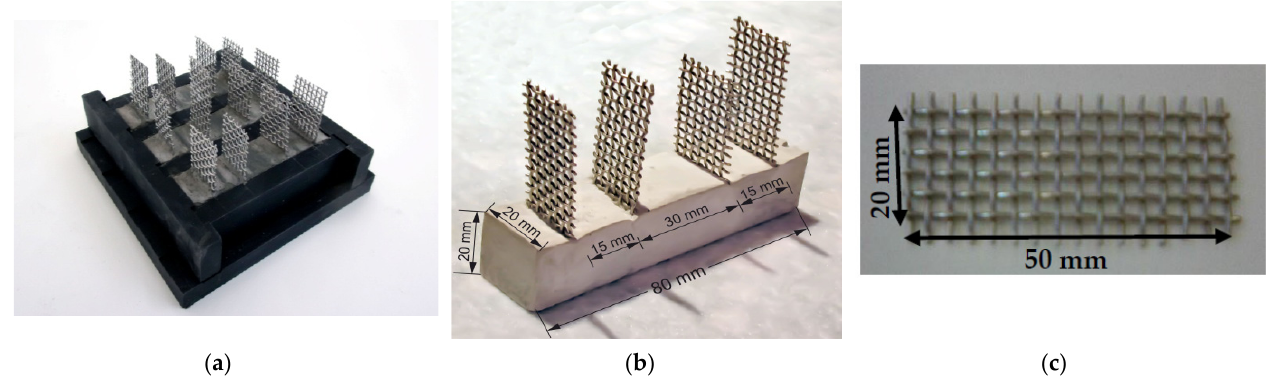
Figure 4. Specimens for the electrical resistance tests ( a ) inside the mold write after casting, ( b ) after demolding, and ( c ) stainless steel mesh embedded inside the samples.